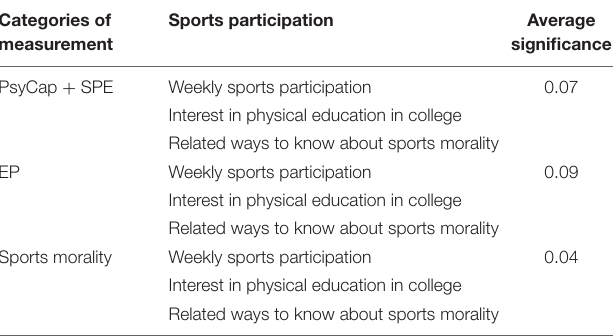
TABLE 12 | College entrepreneurs’ statistical difference under sports participation dimension.